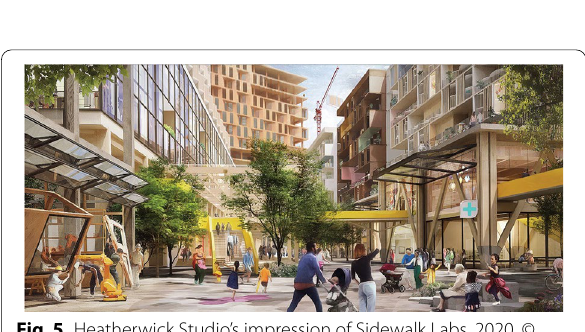
Fig. 5 Heatherwick Studio’s impression of Sidewalk Labs, 2020. © Sidewalk